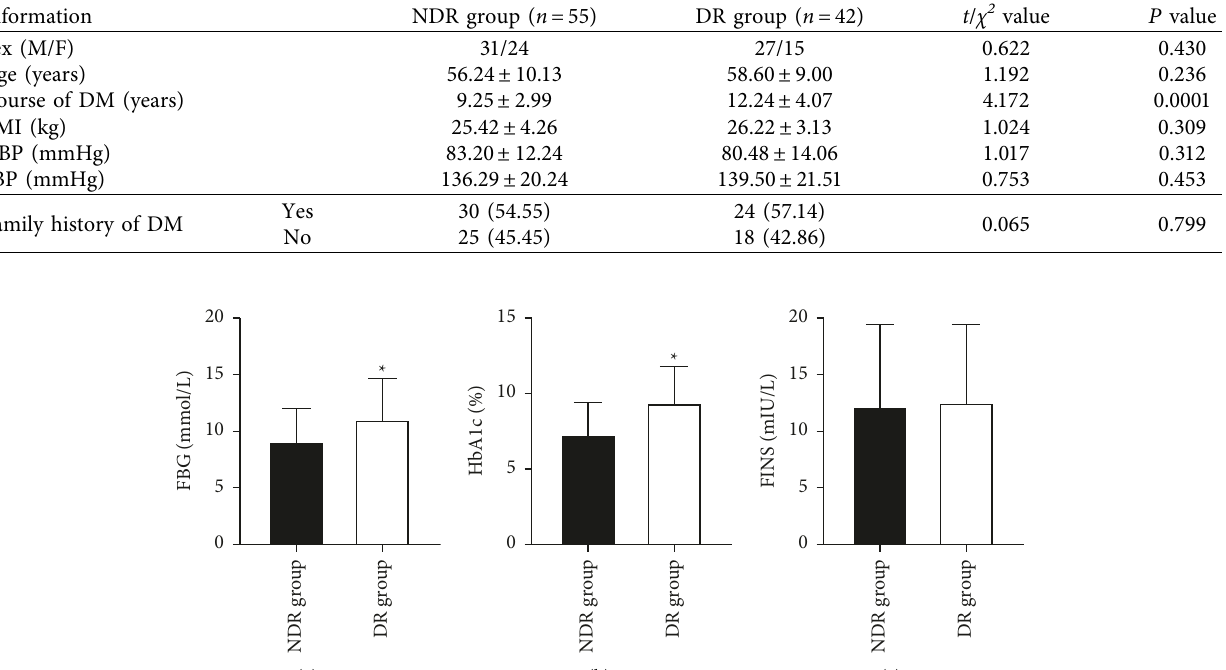
Figure 1: Comparison of glucose metabolism levels between the two groups ( n x respectively; indicates a significant difference between the DR and NDR groups ( P ∗